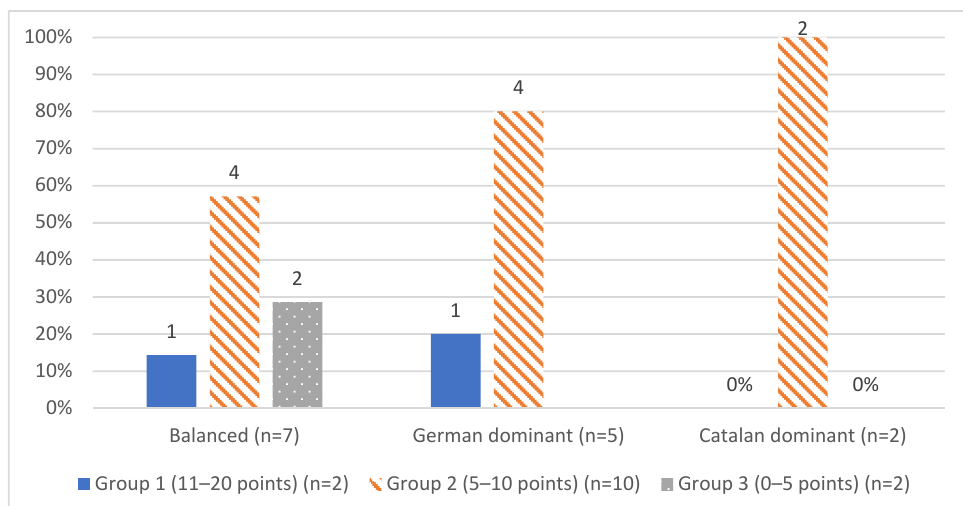
Figure 6. Children’s language dominance and parents’ knowledge of the L2 Catalan Error! Reference source not found. .